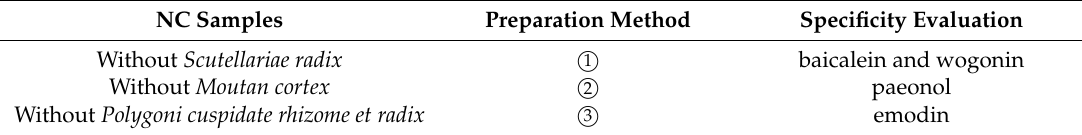
Table 1. Information and preparation protocols of negative control